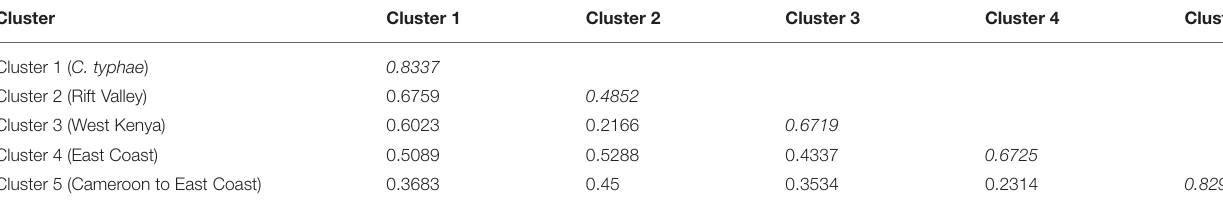
TABLE 2 | F-statistics for each cluster inferred by Instruct on female individuals.